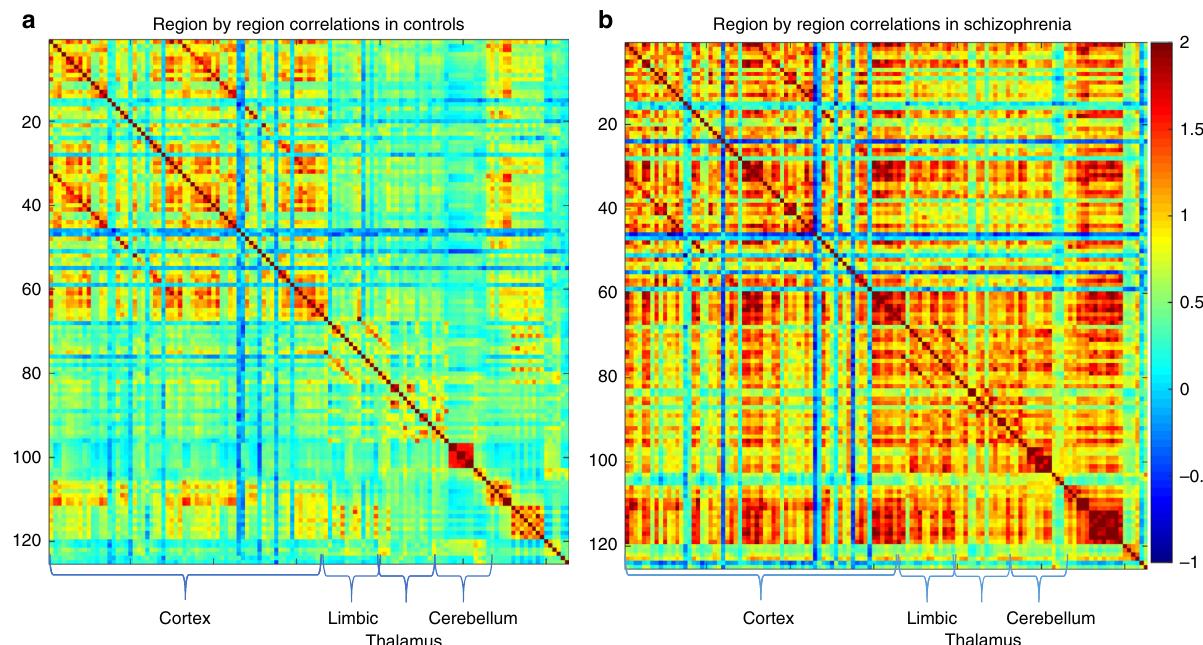
Fig. 3 Matrices showing region-by-region correlations, represented as Z scores, throughout the whole brain (125 ROIs) by group. X and Y axes represent BP ND values across the 125 ROIs de fi ned by the Clinical Imaging Centre (CIC) atlas. a shows data for controls. b shows data for patients. The colour bar represents the strength of correlation expressed as a Z-score (red = high positive correlation, blue = high negative